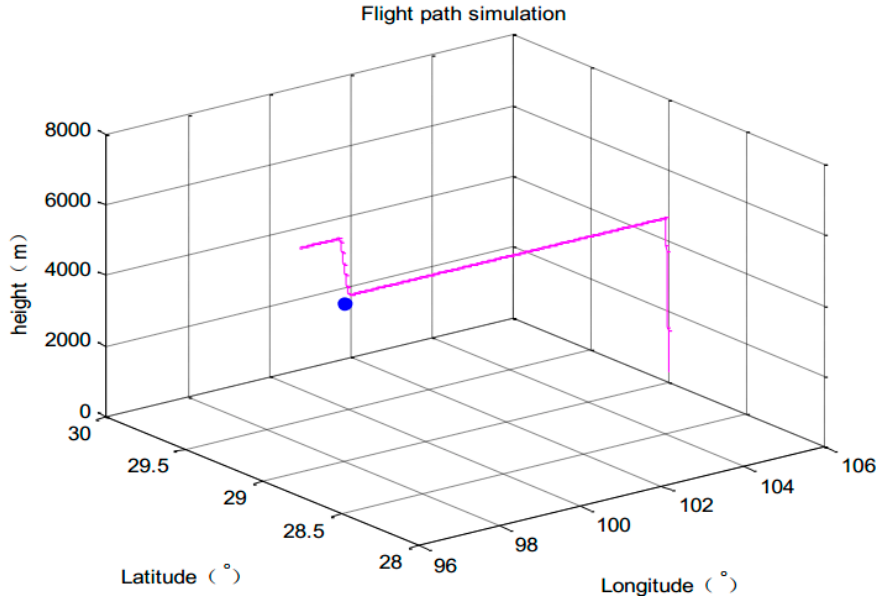
Figure 15. Track graph of simulating maneuvering avoidance during Figure 14. Track graph of simulating maneuvering avoidance during RA.